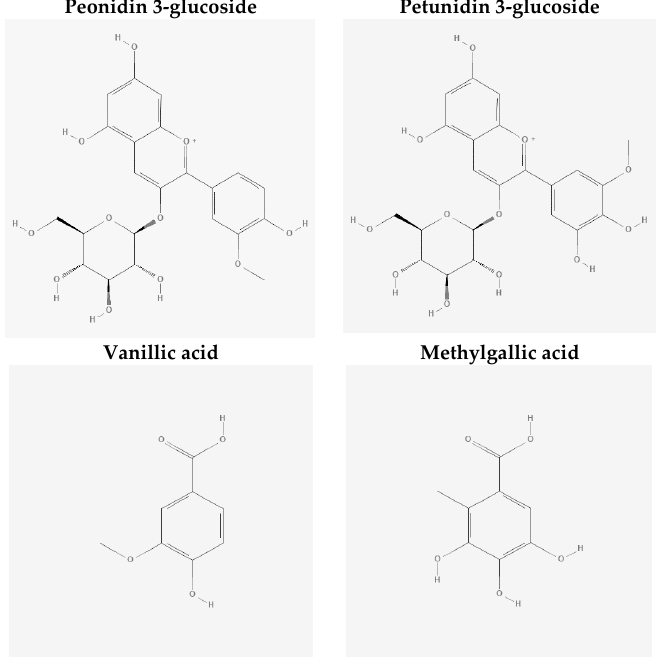
Figure 1. Chemical structure of peondin and petunidin-3-glucoside, vanillic and methylgallic